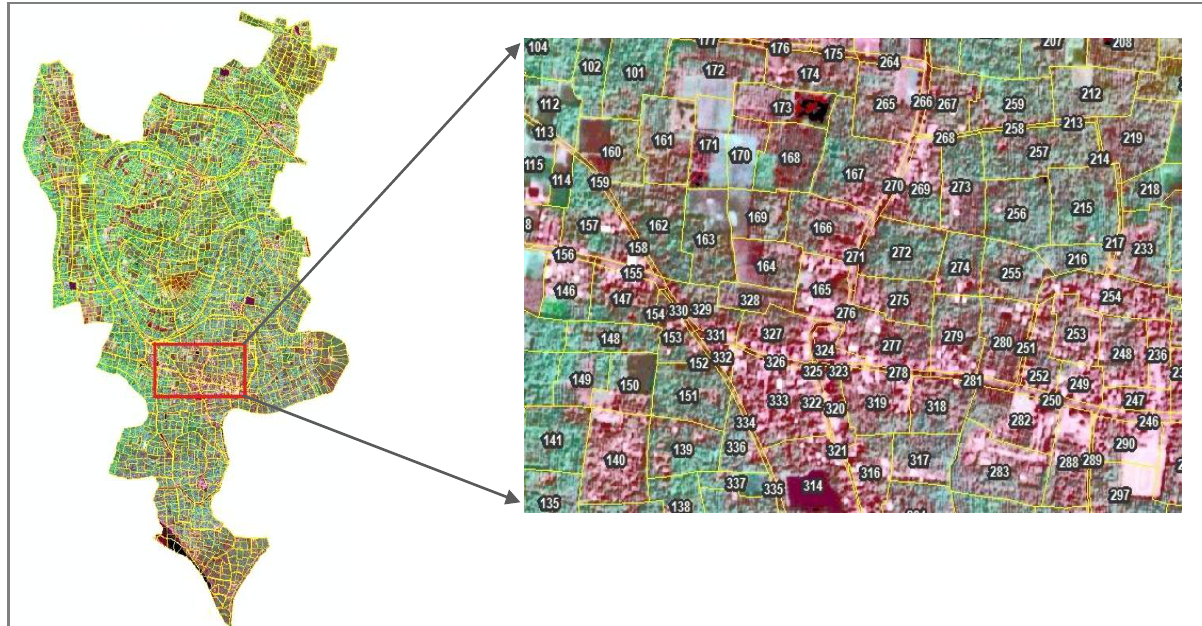
Figure 4: Cadastral parcel boundary layer overlaid on